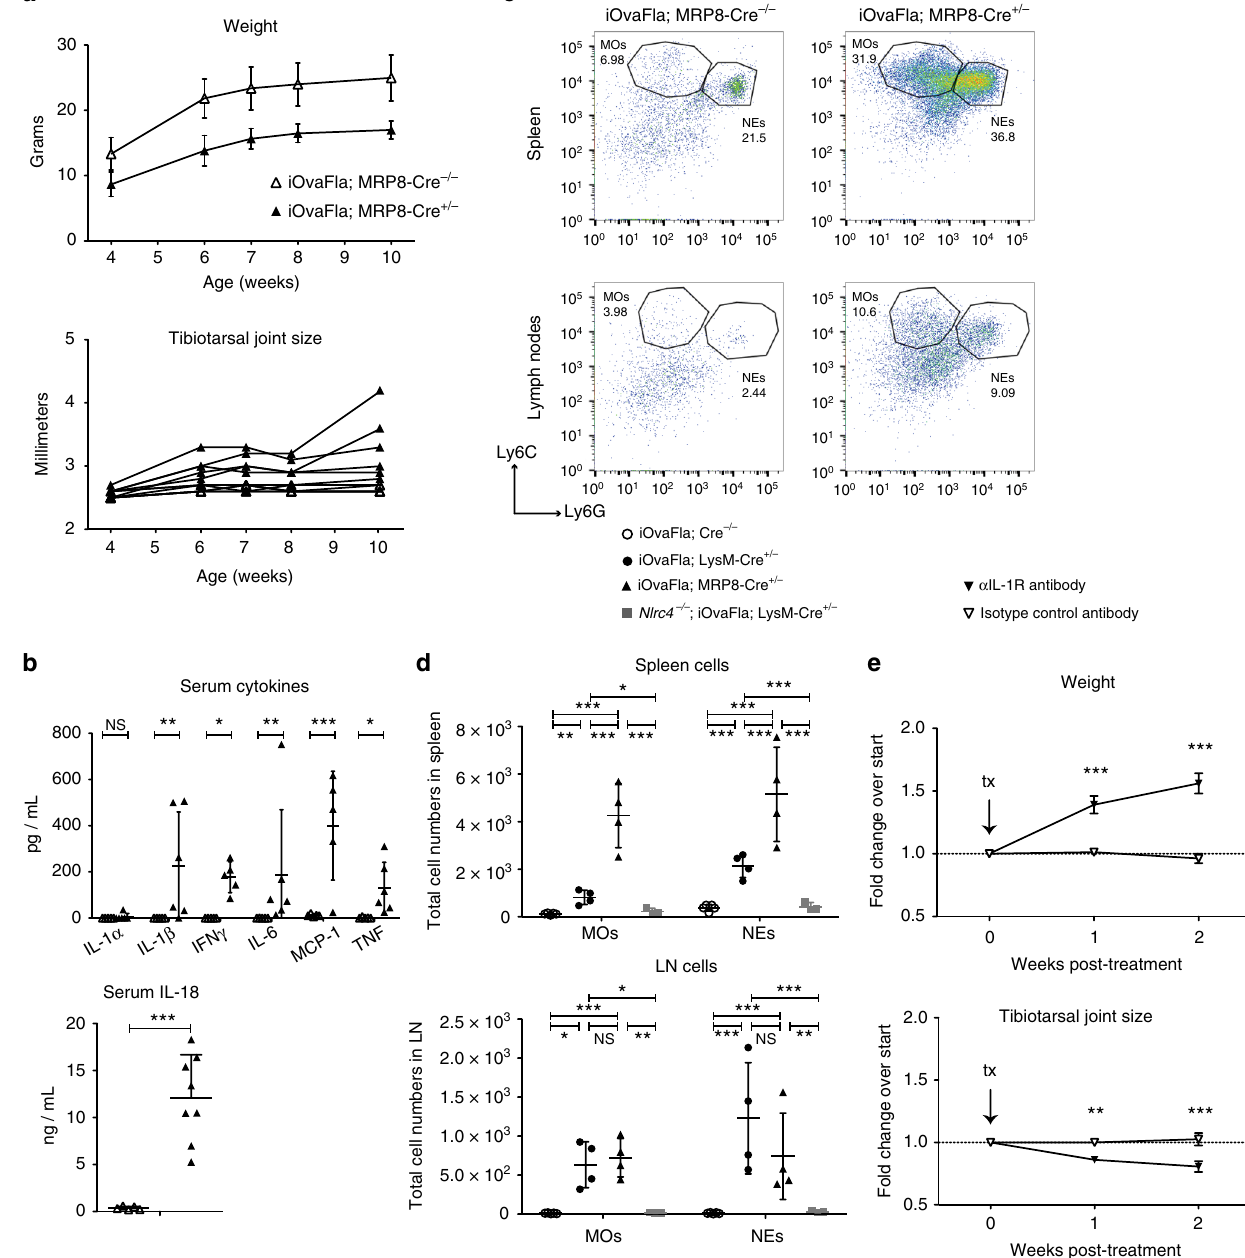
Fig. 7 Neutrophil iOvaFla expression is suf fi cient for in fl ammatory disease. a Weight and tibiotarsal joint swelling as iOvaFla; MRP8-Cre − / − and iOvaFla; MRP8-Cre +/ − mice age ( n = 6 biological replicates per genotype). b Serum cytokines measured by a BD Biosciences cytokine bead array and IL-18 ELISA of 10 – 12-week-old mice. c Flow cytometry and d quanti fi cation of monocytes (MO; CD11b + Ly6C Hi Ly6G Lo ) and neutrophils (NE; CD11b + Ly6C Lo Ly6G Hi ). For each fl ow cytometry plot, the top row is from the spleen and the second row from peripheral and mesenteric lymph nodes. Each column represents a different genotype. e Weight and tibiotarsal joint measurements after OVA-Fla; MRP8-Cre +/ − mice were administered either anti-IL-1R blocking antibody or isotype control every 3 – 4 days for 2 weeks ( n = 3 biological replicates per treatment). Data in b – d are representative of three independent experiments. Error bars are s.d. Results were analysed with either a Mann – Whitney test or two-way ANOVA and Bonferroni post-tests; * p < 0.05, ** p < 0.01, *** p < 0.001